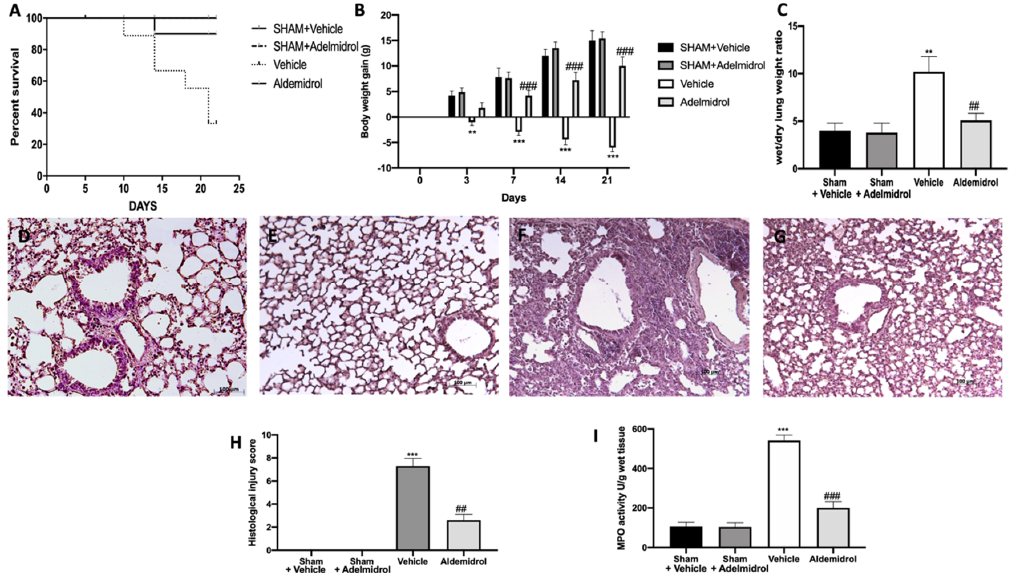
Figure 4. E ff ect of adelmidrol on the survival rate, body weight, lung edema, histological changes, MPO activity, and fibrosis: Survival rate ( A ); body weight gain ( B ); wet / dry lung weight ratio ( C ); hematoxylin and eosin staining of sham + vehicle ( D ), sham + adelmidrol ( E ), vehicle ( F ), and adelmidrol ( G ); histological injury score ( H ); MPO activity ( I ). ** p < 0.01 vs. sham + vehicle, ## p < 0.01 vs. vehicle, *** p < 0.001 vs. sham + vehicle, and ### p < 0.001 vs.